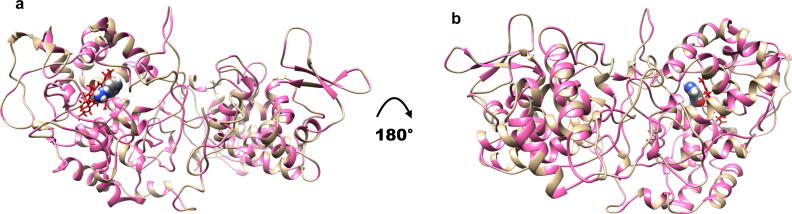
Structure of katG in complex with the drug isoniazid (INH) coloured by 378 mutational positions linked to 571 SNPs. Areas marked in pink are associated with one or more mutations. HEM is denoted in red, INH is denoted as spheres. Parts a) and b) denote the structure in two different orientations, rotated by 180°. Figure rendered using UCSF Chimera, Version 1.13.1. (For interpretation of the references to colour in this figure legend, the reader is referred to the web version of this article.)